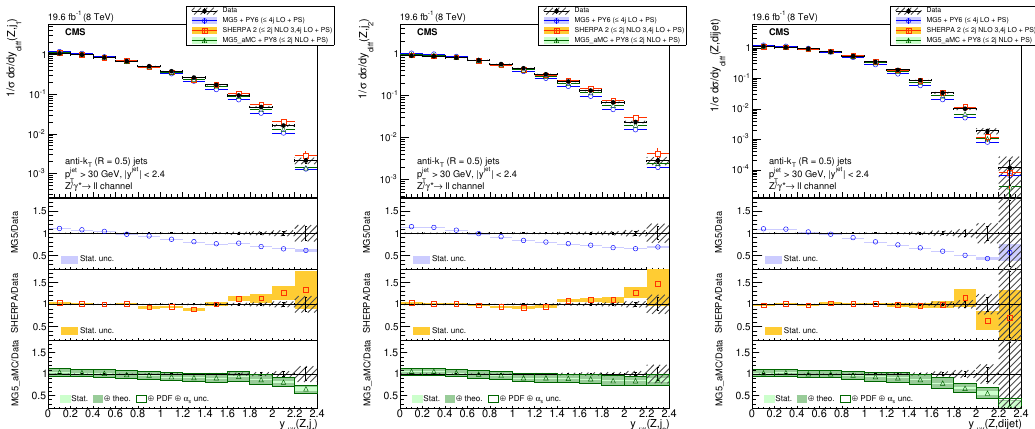
Figure 11 . The normalised di(cid:11)erential cross section for Z ( ! ‘‘ )+jets ( N jets (cid:21) 2) production mea- sured as a function of the y di(cid:11) of the Z boson and (left) the leading jet, (middle) the second-leading jet, and (right) the system constituted by these two jets. The measurement is compared to the predictions calculated with MadGraph 5 + pythia 6, sherpa 2, and mg5 a mc + pythia 8. The lower panels show the ratios of the theoretical predictions to the measurements. Error bars around the experimental points show the statistical uncertainty, while the cross-hatched bands indicate the statistical and systematic uncertainties added in quadrature. The boxes around the mg5 a mc + pythia 8 to measurement ratio represent the uncertainty on the prediction, including statistical, theoretical (from scale variations), and PDF uncertainties. The dark green area represents the statistical and theoretical uncertainties only, while the light green area represents the statistical uncertainty alone.